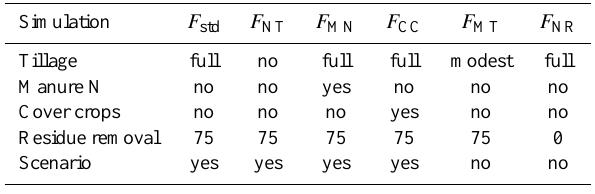
Table 2. Simulation settings used for the comparison of soil C, yields and N leaching with different agricultural management types. For implementation of full vs. moderate tillage, see Sect. 2.1.1. In